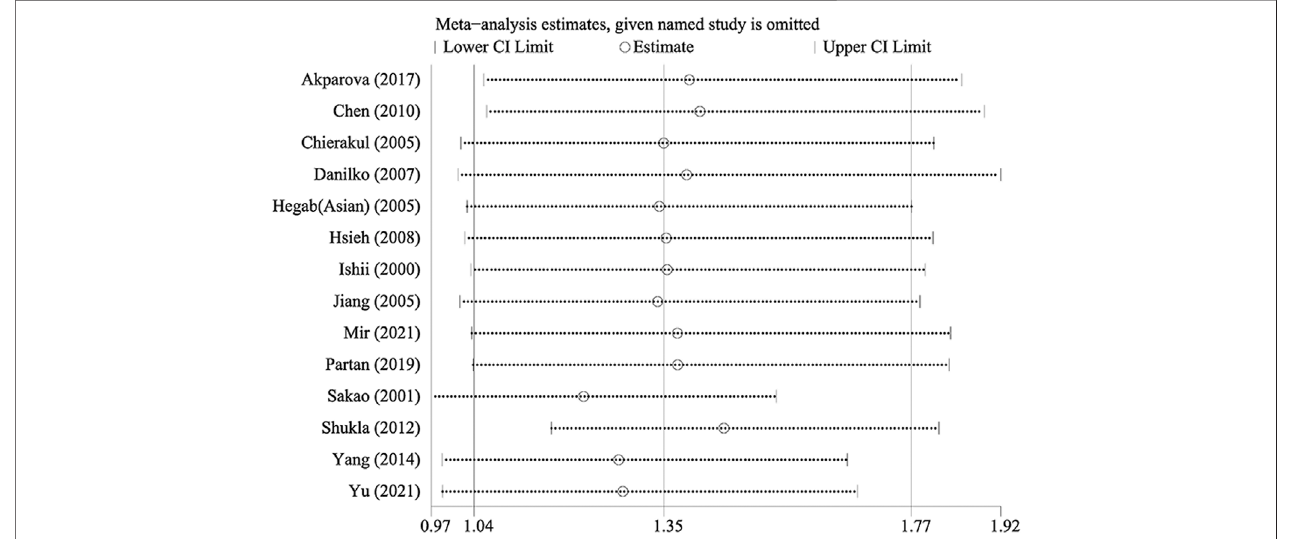
FIGURE 3 | Sensitivity analysis of TNF- α -308 polymorphism and COPD risk (Asian population for GA vs. GG).